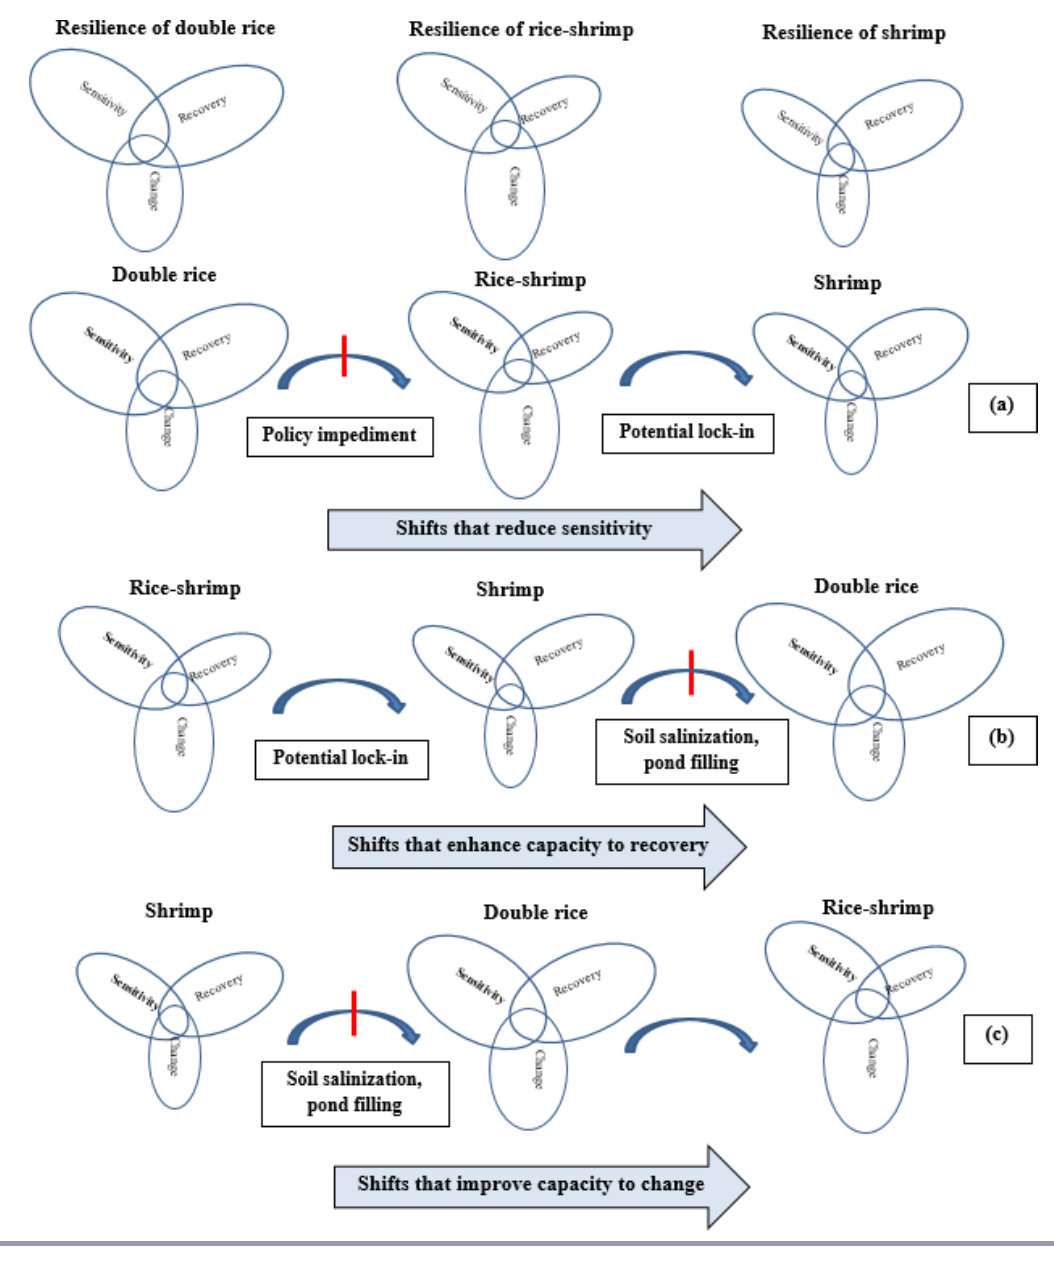
Fig. 3 . Resilience and changes in resilience factors by shifting agricultural systems in the Mekong Delta (the bigger the propeller, the higher the sensitivity, recovery, or ability to change of agricultural systems). The shift from one system to another will help to reduce the sensitivity of the system to salinity intrusion (a), increase the capacity to recover (b), or improve the capacity to change (c). These shifts consequently increase the sensitivity (b and c: from shrimp to double rice), reduce the capacity to recover (a and c: from double rice to rice-shrimp), or degrade the capacity to change (a: from double rice to rice-shrimp; b: from rice-shrimp to shrimp). The red blocks indicate shifts that are either very difficult or not currently